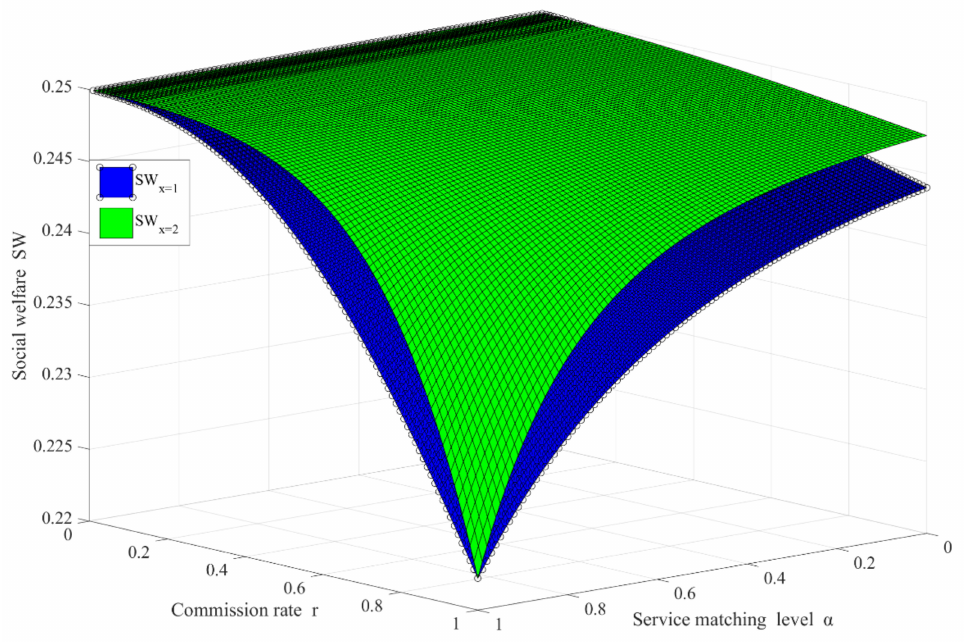
Figure 7. Level of platform data usage x on social